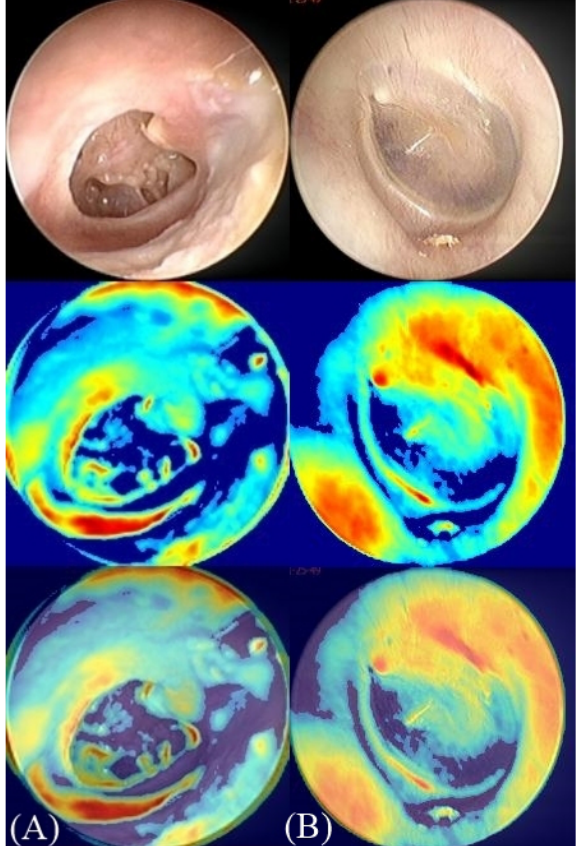
Figure 3. Class activation maps (CAM). CAM is a colored representation of data where different values are represented as different colors with values ranging from blue to red (blue, cyan, green, yellow, red). The red regions in the overlay image represent the most specific discriminative parts of the image by the deep neural network. The blue regions represent the non-specific part. ( A ) Right side tympanic membrane (TM) image with perforation. ( B ) Left side TM image without perforation.